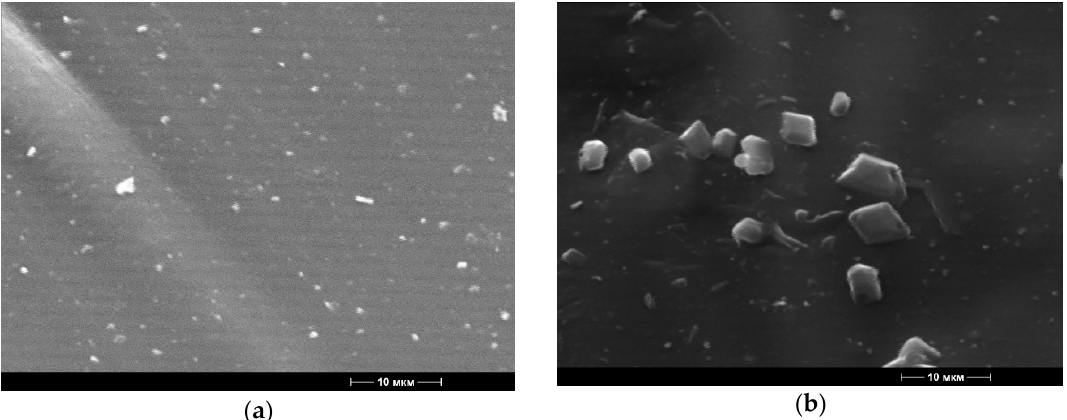
Figure 3. Microphotographs of the surface structure of the materials (5000 × magnification) based on polyethylene with 5.0% content of birch bark extract, received with the use of ultrasonic treatment ( а ) and without the use of ultrasonic treatment ( b ).